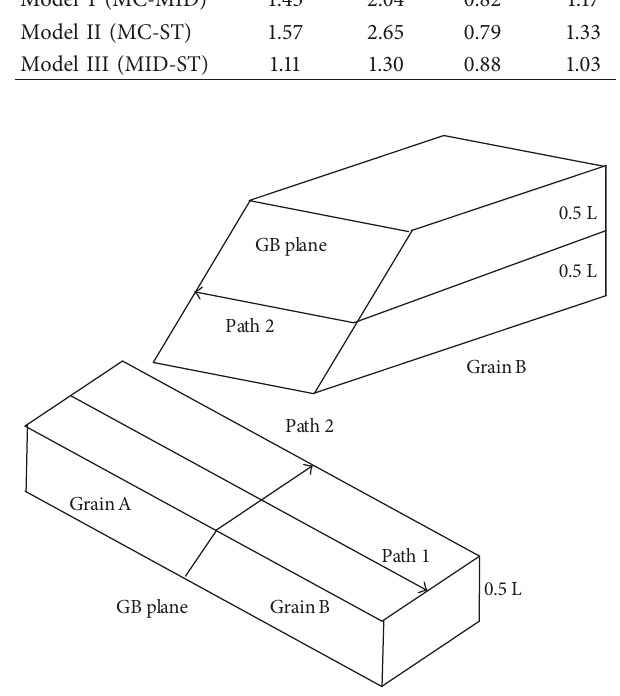
Figure 6: Locations of the two paths to determine the stress concentration factor.